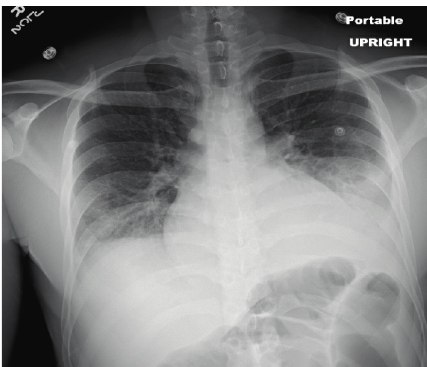
Figure 2: Chest X-ray revealing bilateral pleural effusions right middle lobe